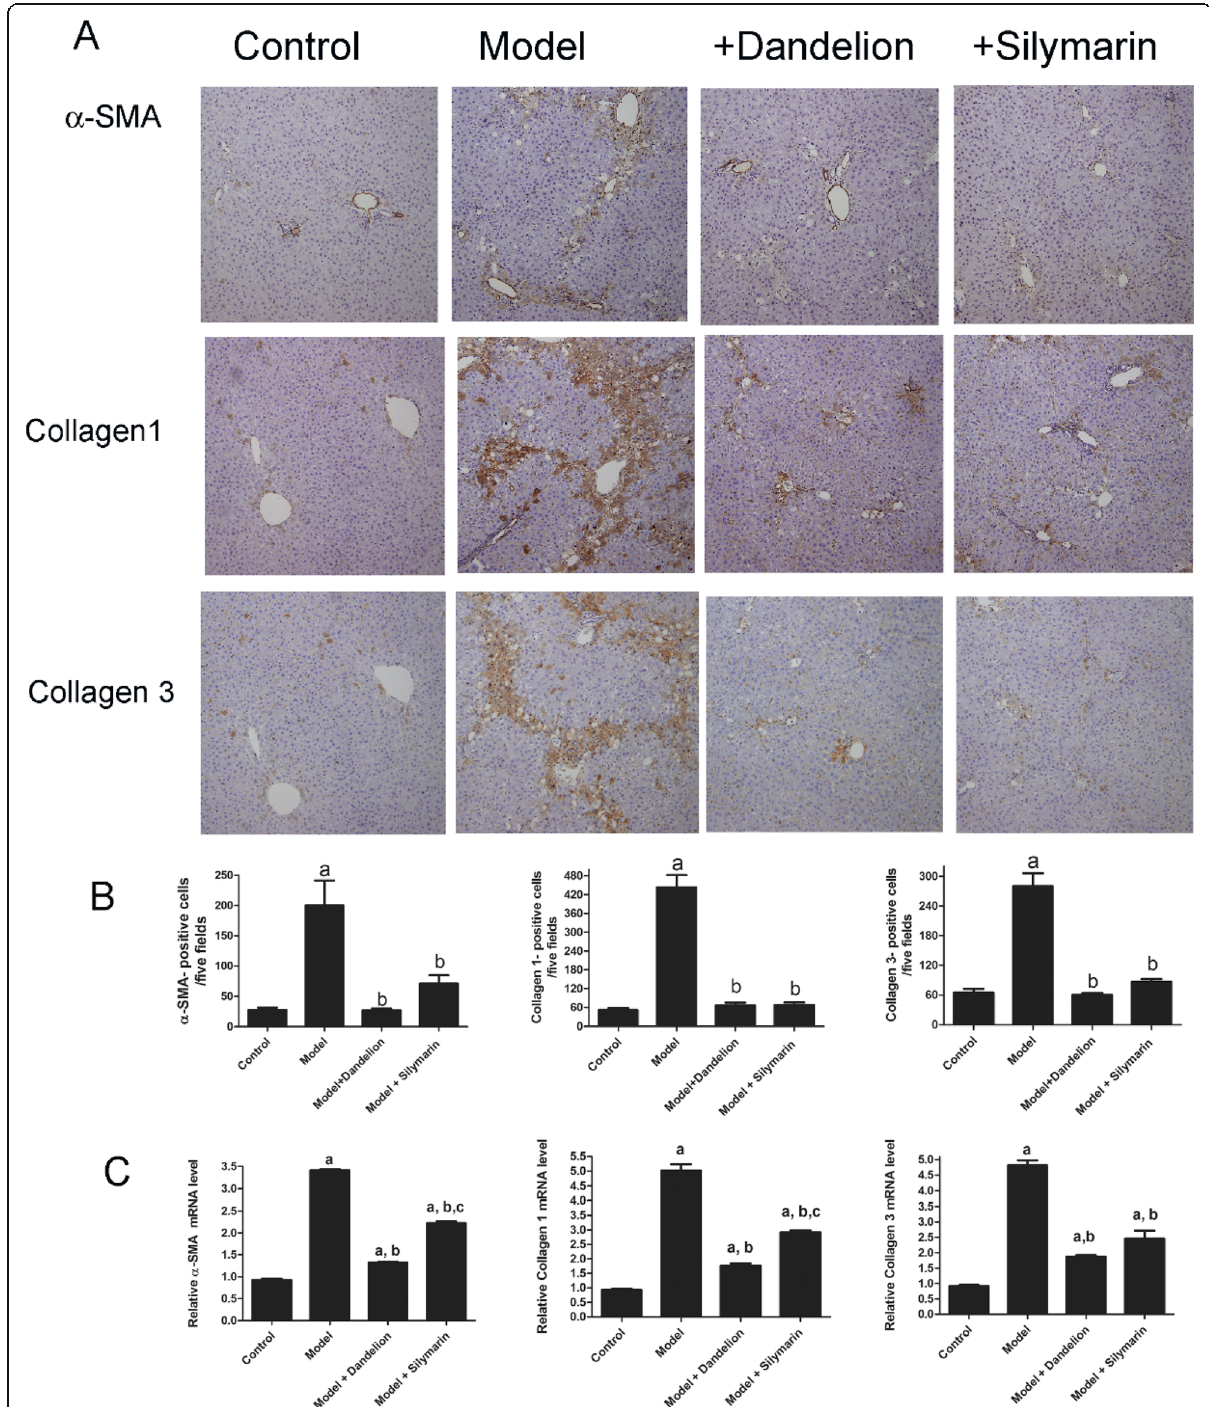
Fig. 5 (See legend on next